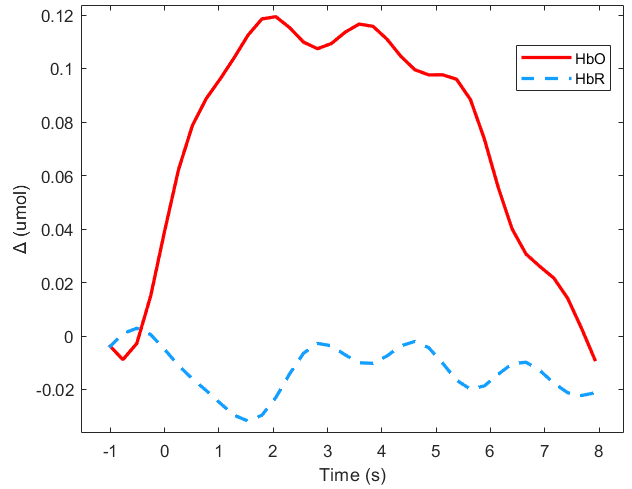
Figure 3. Average of the hemodynamic evoked response in the deaf group during animated road scene processing in the frontal region.